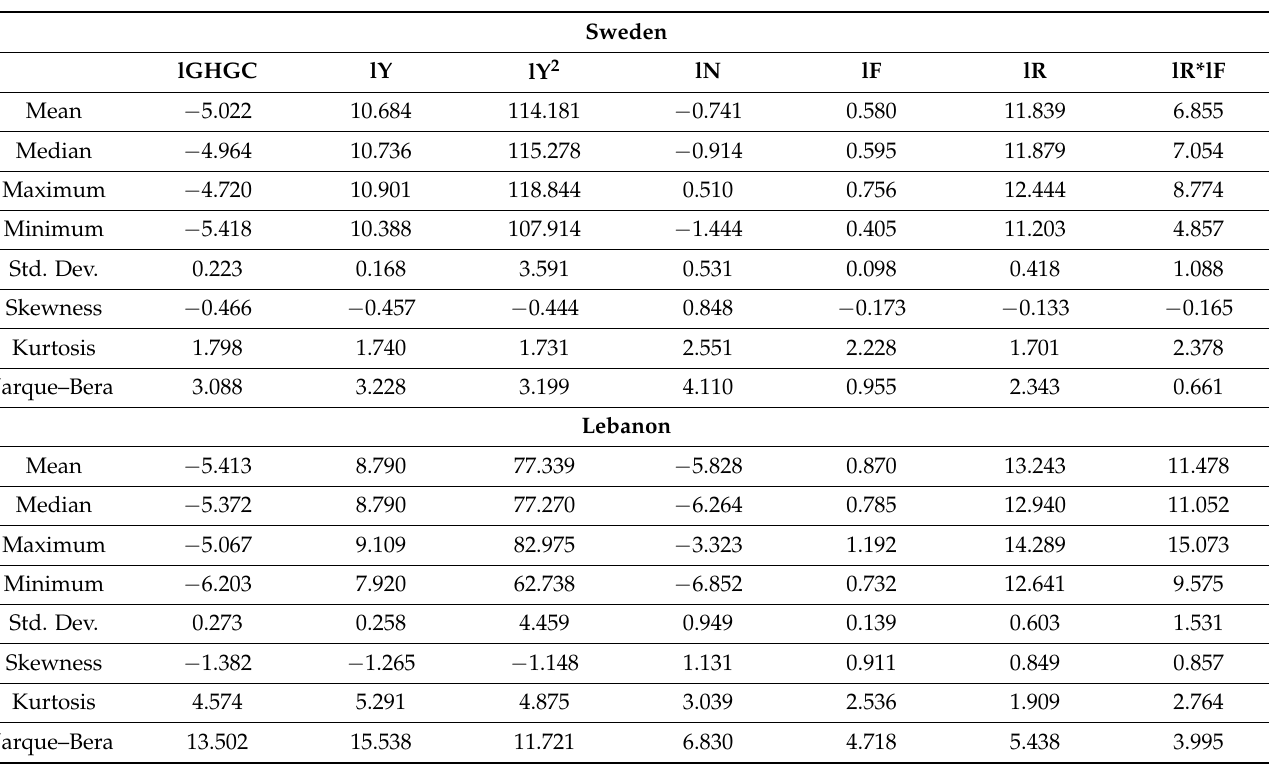
Table 4. Descriptive